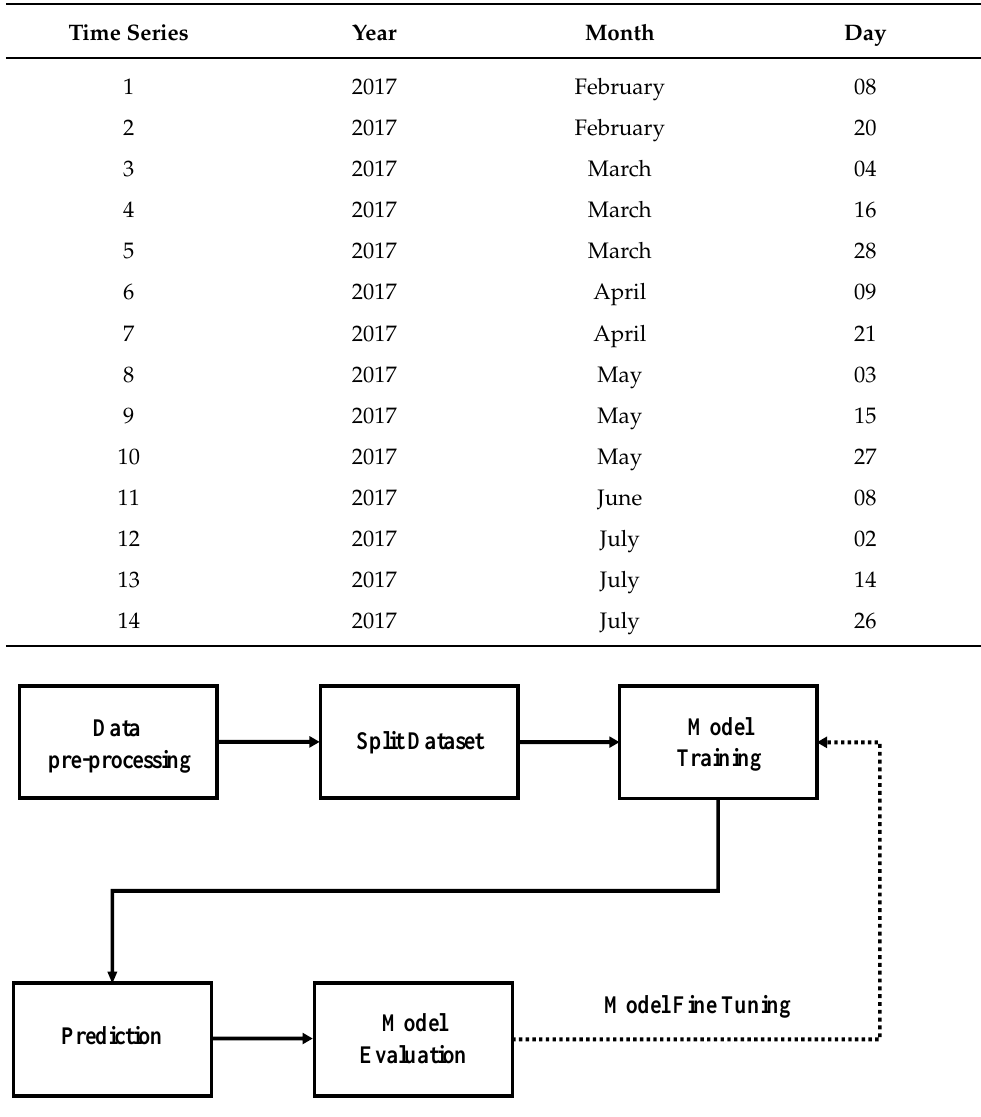
Table 1. The complete sensing dates of the Sentinel-1A SAR data used in this study.